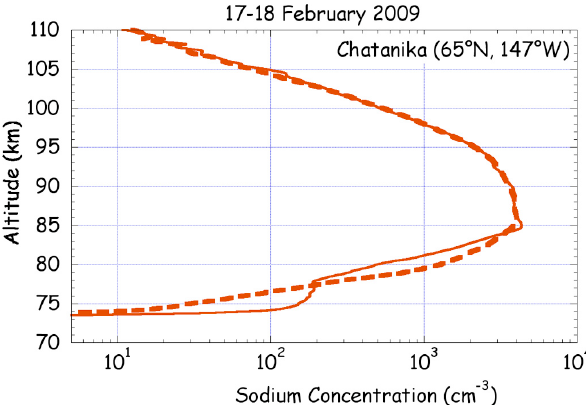
Fig. 3. Sodium concentration measured by resonance lidar at Chatanika, Alaska on the night of 17–18 February 2009. The concentration is plotted in false color as a function of time (LST=UT − 9h) and altitude. The concentrations have been low pass filtered with Parzen filters having cut-offs of 1km and 2h. The contour levels are 100cm − 3 , 250cm − 3 , 500cm − 3 , ... 4750cm − 3 . The two vertical lines mark when the rocket-borne ionization gauges made their measurements.